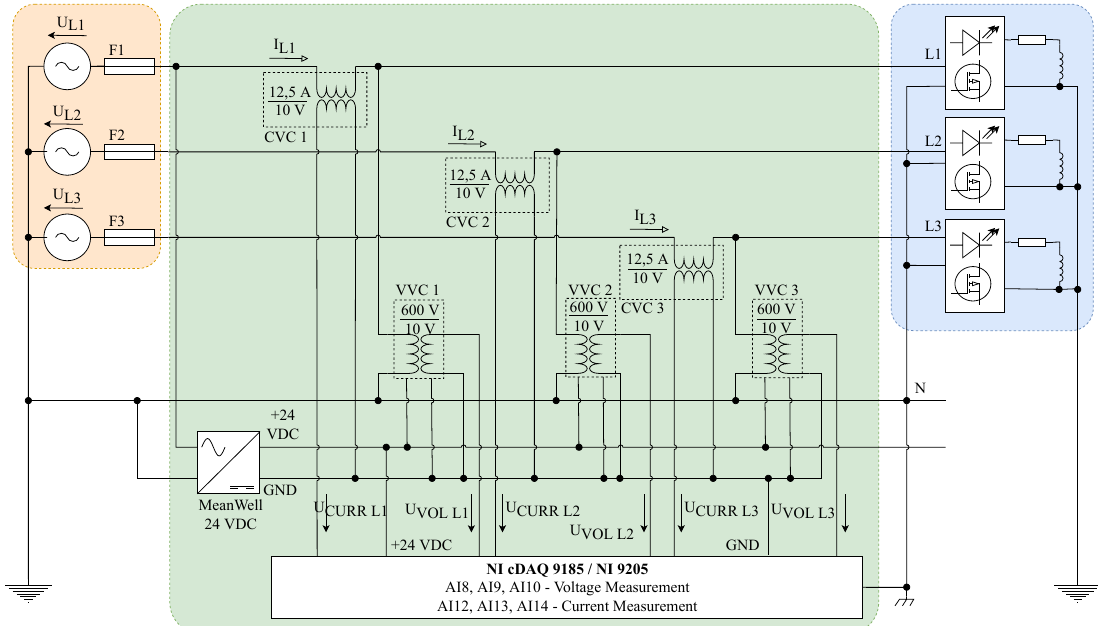
Figure 8. Measurement system wiring diagram.